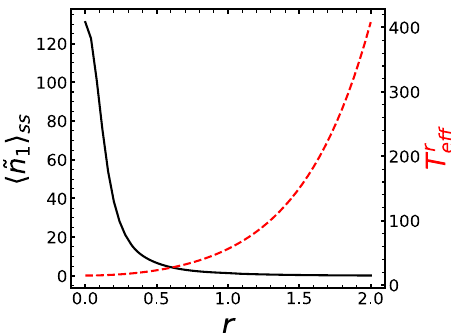
Fig. 6 Cooling assisted by a squeezed thermal bath. The steady-state mean phonon number h ~ n 1 i , and effective temperature T r of the squeezed eff ss thermal bath as a function of the squeezing parameter r . Solid, and dashed lines are for mean phonon number h ~ n 1 i and effective temperature T eff , ss respectively. Parameters are ω a = 2 π × 7 GHz, ω 1 = 2 π × 10 MHz, g 1 = 2 π × 100 kHz, κ c = 2 π × 1 MHz, ~ κ h ¼ 2 π ´ 1 : 5 MHz, κ 1 = 2 π × 32 Hz, and T 1 = T c ≈ i 65 mK. For h ~ n , all the parameters are scaled with the microwave 1 ss resonator frequency ω a = 2 π × 7 GHz, and the squeezed thermal bath ¼ effective temperature T r is calculated in SI units for (cid:2) n h eff